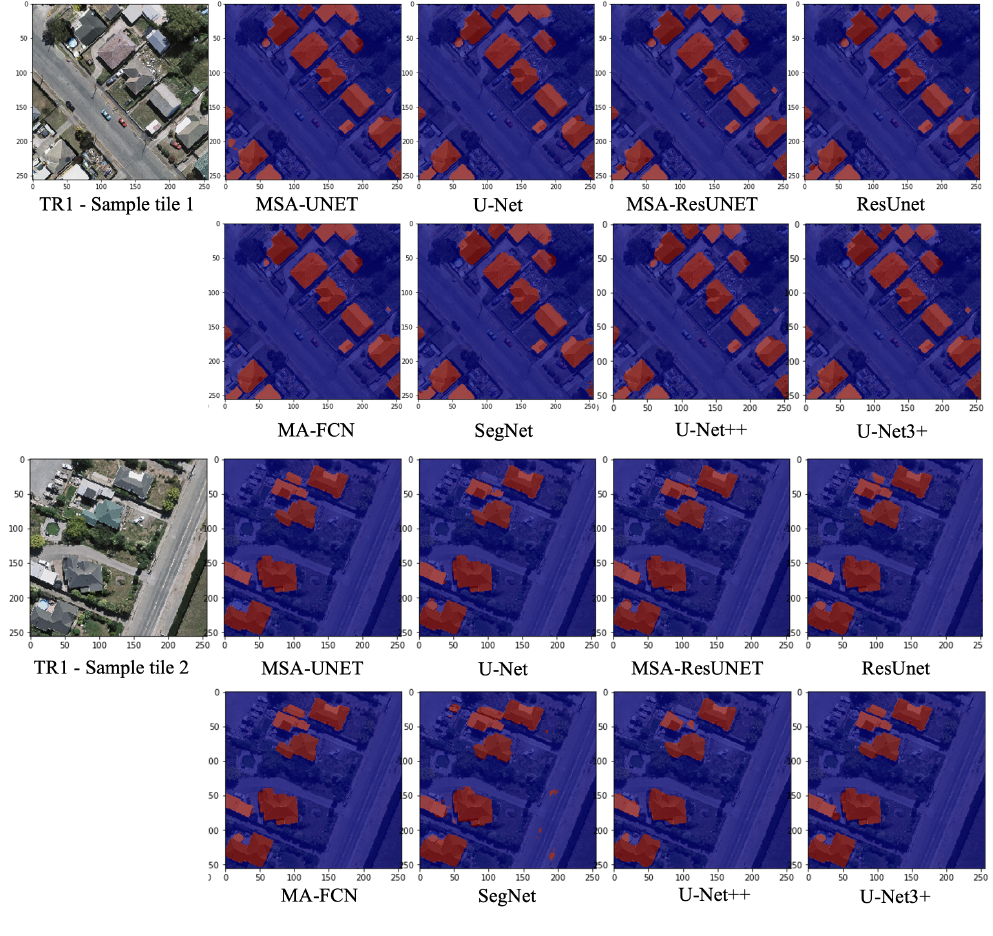
Figure 6. Sample results from the MSA-UNET, U-Net, MSA-ResUNET, ResUNET, MA-FCN, SegNet, U-Net++, and U-Net3+ on the WHU Building dataset (TR1). The left-most images are two different samples from TR1 followed by the corresponding outputs from the eight base models. Table 3. Cross-domain validation results on TR1 and TR2. M1(TR1) and M1(TR2) refer to the base models trained on TR1 and TR2, respectively. To show the effects of the domain-shift, M1(TR1), and M1(TR2) are validated against TR2 and TR1,